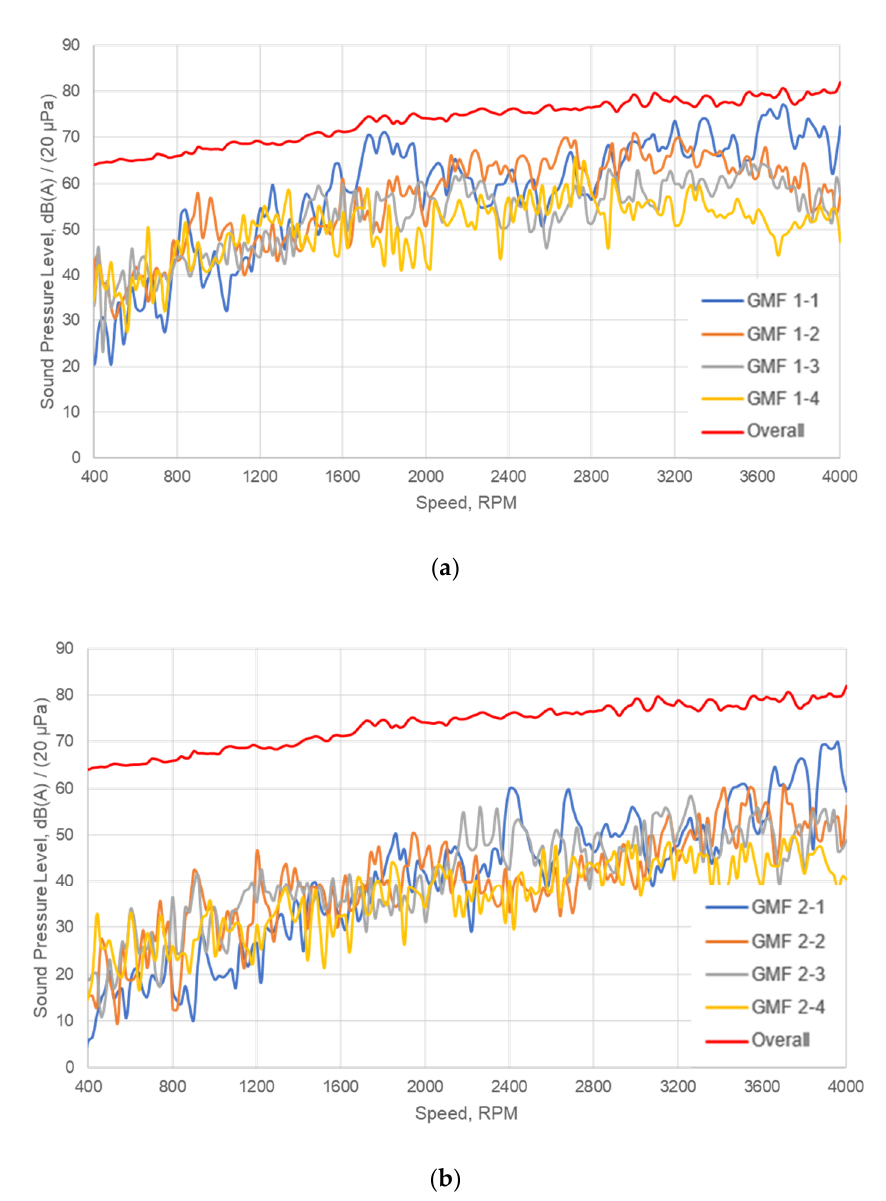
Figure 8. Sound pressure level comparison to the overall noise. ( a ): At gear mesh frequency of stage 1 (first to fourth harmonics); ( b ): At gear mesh frequency of stage 2 (first to fourth harmonics). The radiated noise measured in the gearbox was caused by structural vibration of the housing.